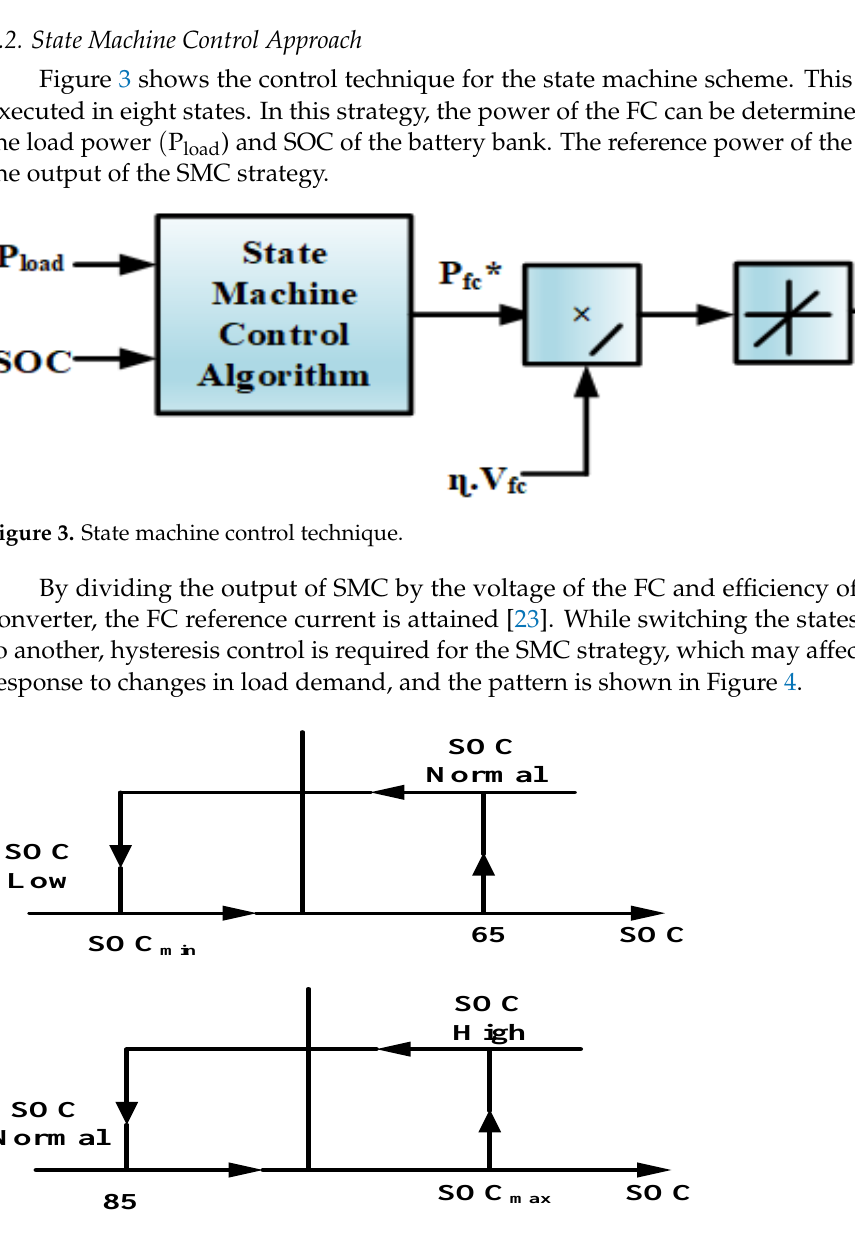
Figure 4. State machine control hysteresis.